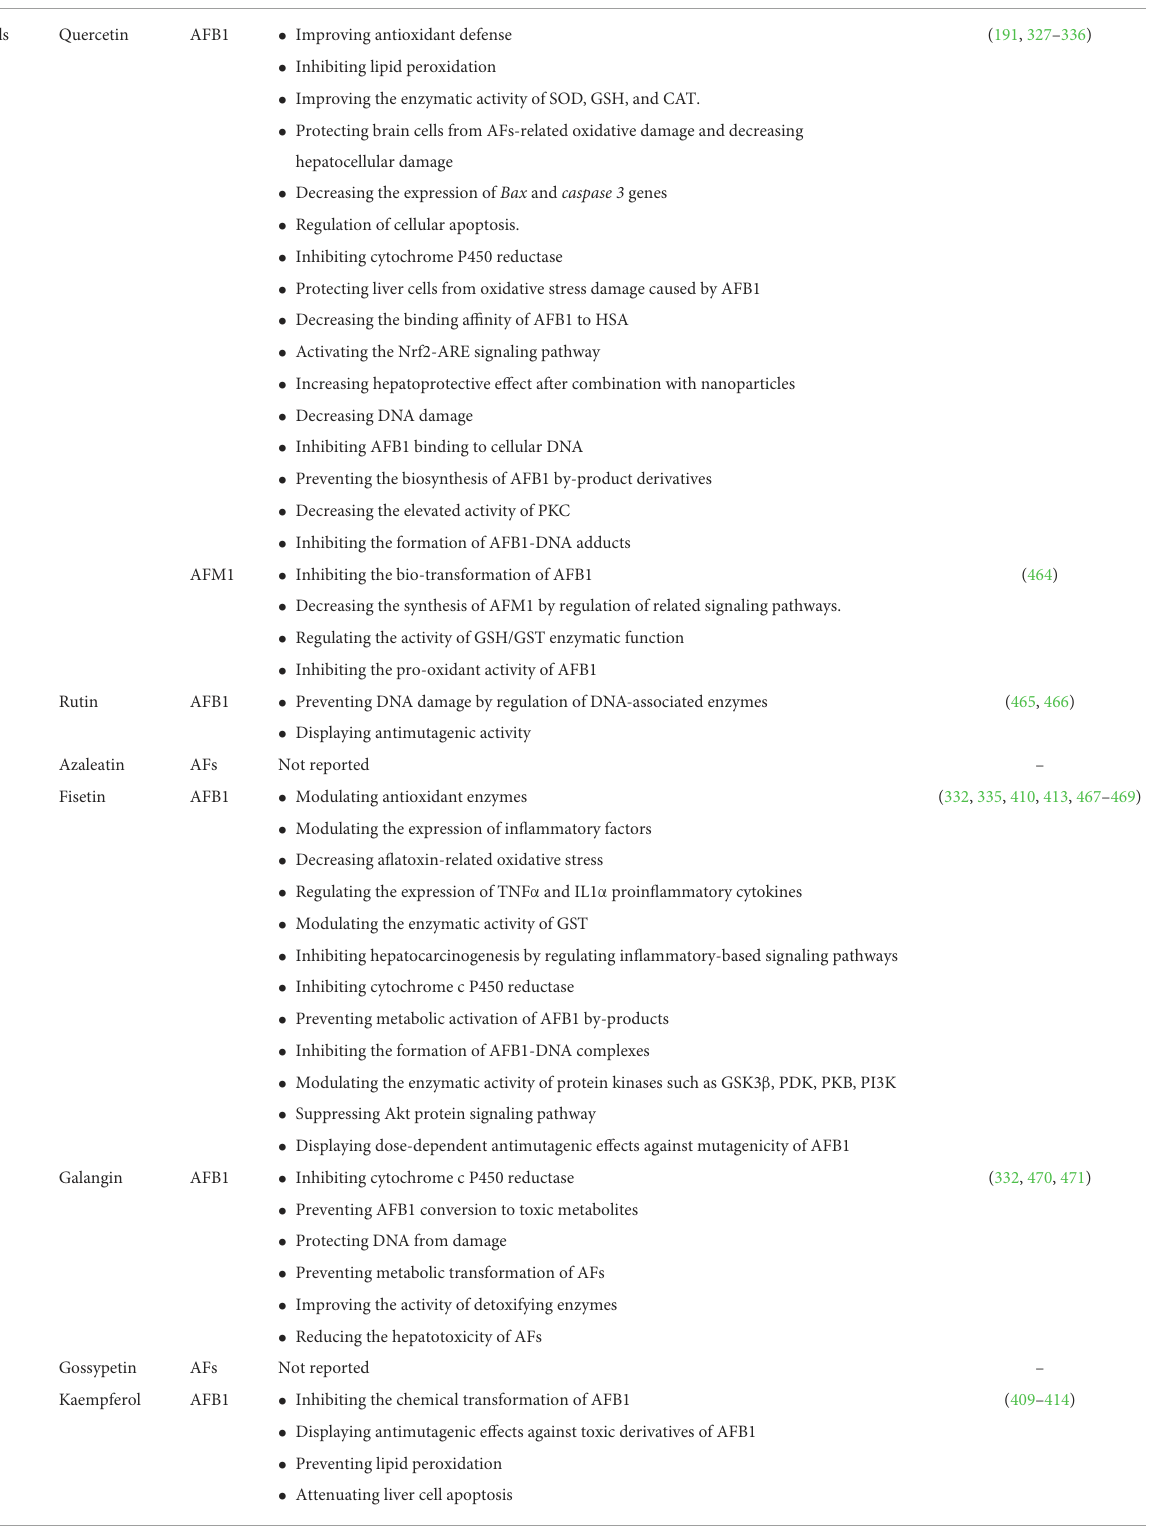
TABLE 1 The possible anti-AFs mechanism of action of